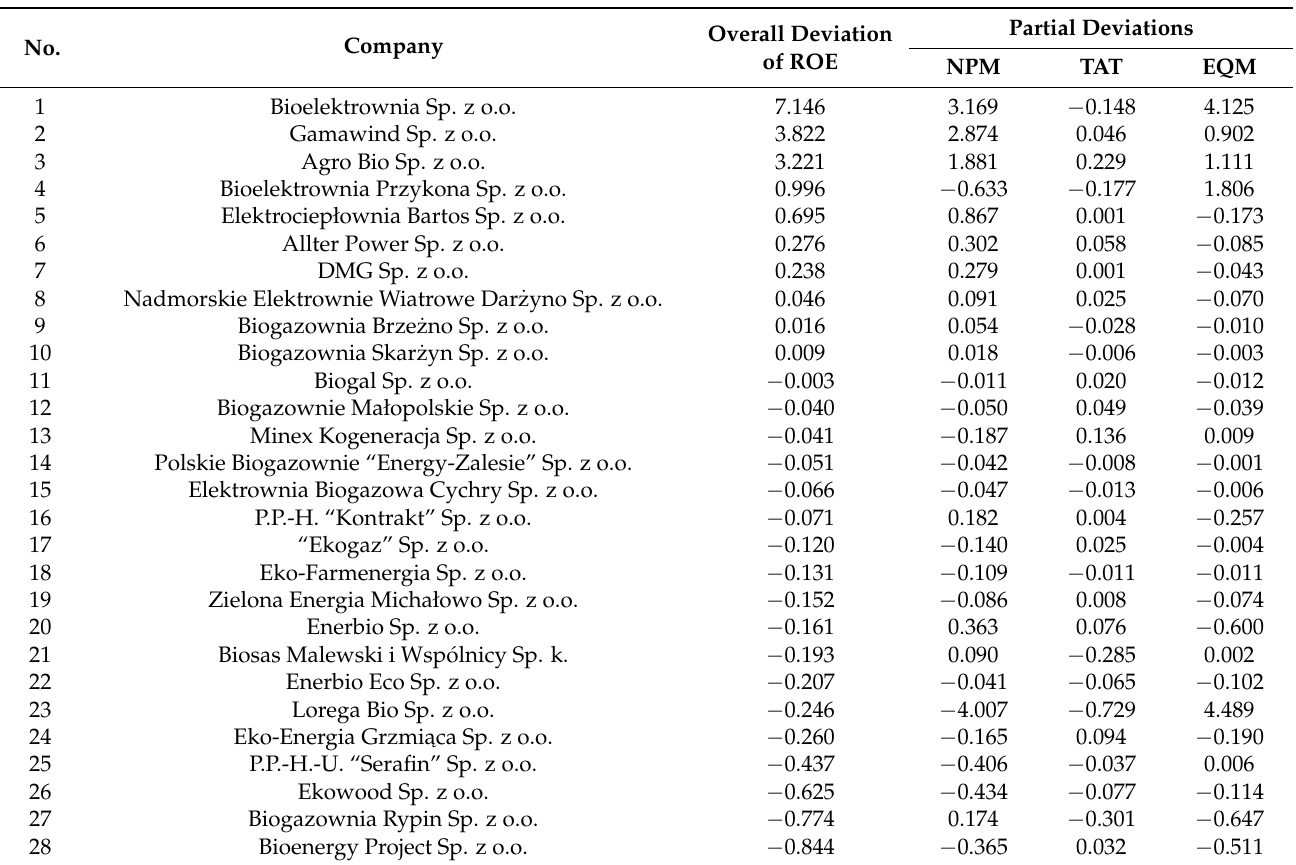
Table A1. Results of causal analysis using the Du Pont model for 2019.